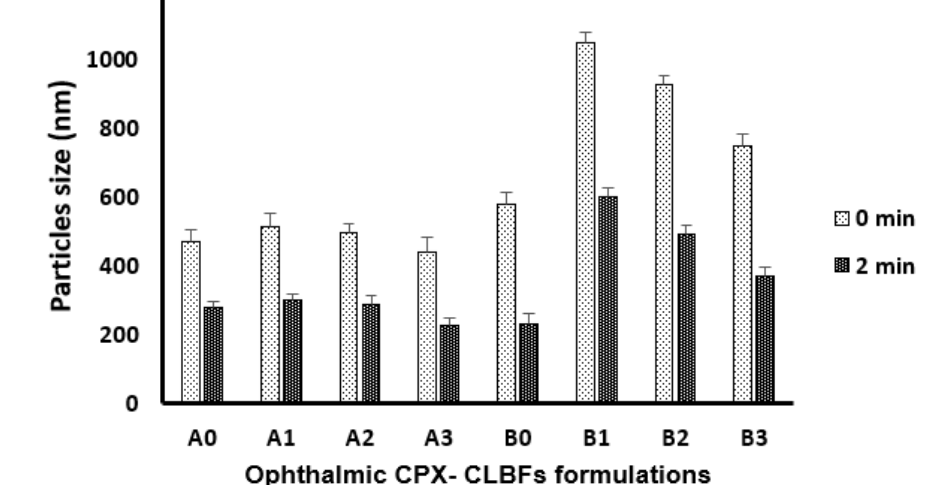
Figure 1. Effect of sonication time on particle size of ophthalmic ciprofloxacin (CPX) colloidal lipid-based formulations (CPX-CLBFs) (mean ± SD, n = 3.0).